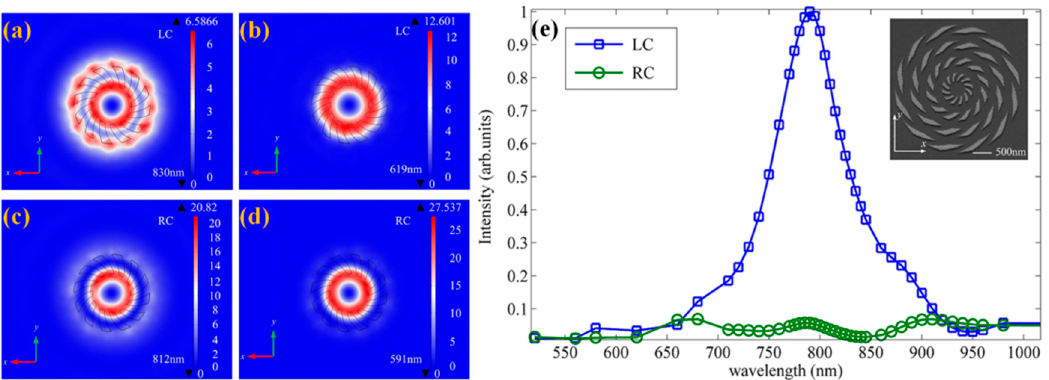
Figure 15. ( a – d ) The electric fields’ distributions of E z by spiral-ring structures under LCP and RCP illumination at the peak intensity wavelength; ( e ) relative transmission spectra of a metallic spiral four-ring structure under LCP and RCP illumination, respectively. Inset: the image of the metallic spiral four-ring structure. The field intensity is calculated through an aperture with a radius of 200 nm, which is located 100 nm from the gold surface. Reproduced with permission from [54].